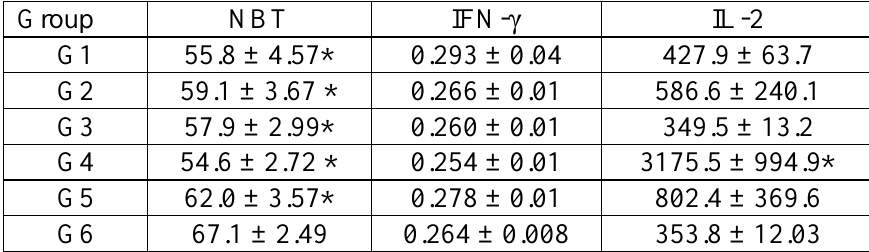
*: Significant difference at level (p<0.05). Table (3): Immunological Results obtained for all